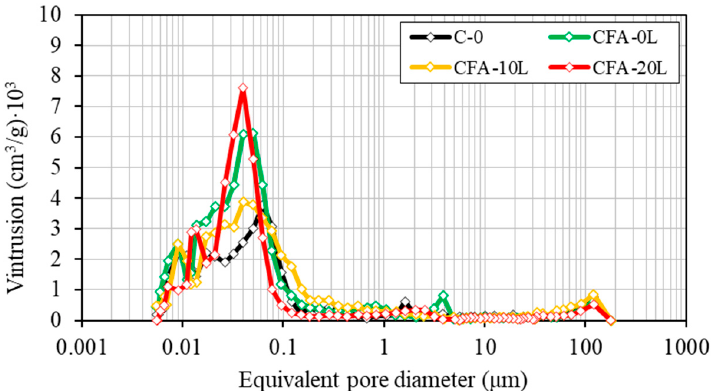
Figure 6. Pore size distribution at the age of 28 days.